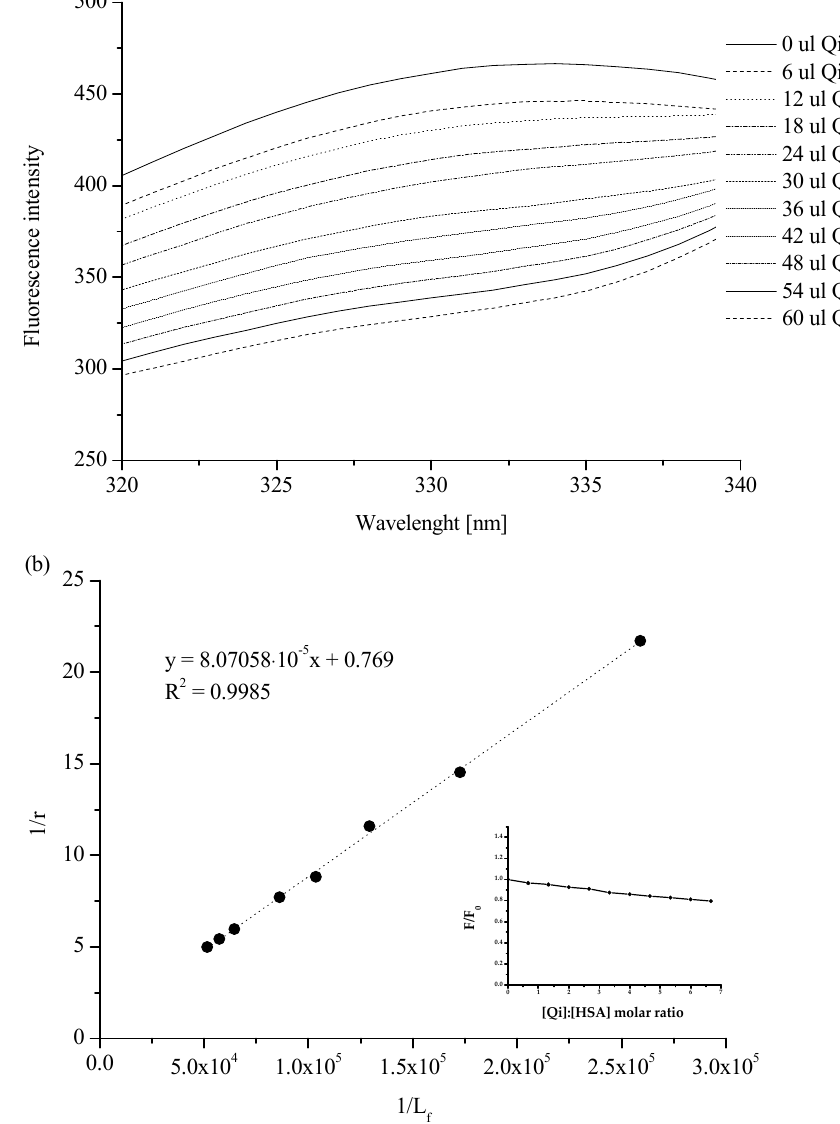
Figure 2. Spectrofluorimetric analysis: ( a ) the fluorescent emission spectra of HSA ([HSA] 3 × 10 − 6 M): without or in the presence of Qi ([Qi] 1 × 10 − 3 M); λ ex 285 [nm]; ( b ) the Klotz plot for HSA in the presence of Qi at Qi:HSA molar ratio from 0.67:1 to 6.67:1. In the insert: quenching of HSA fluorescence by Qi at Qi:HSA molar ratio from 0.67:1 to 6.67:1; λ ex 285 nm; [HSA] 3 × 10 − 6 M; [Qi] 1 × 10 − 3 M; pH = Table 2. The association constant ( K a ) and the number of molecules bound to protein ( n ) in Qi-HSA system; Qi:HSA molar ratio from 0.67:1 to 6.67:1; [HSA] 3 × 10 − 6 M; [Qi] 1 × 10 − 3 M; pH=7.4